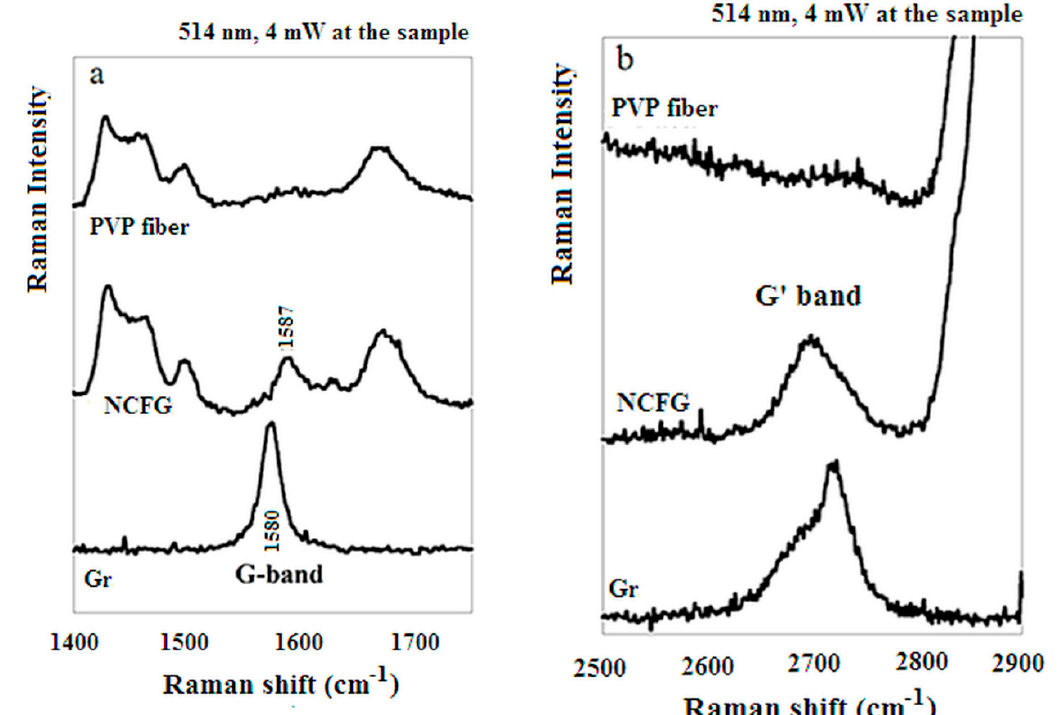
Figure 4. Raman spectra of PVP fibre, Noncovalently Functionalized Graphene (NCFG) and Graphite (Gr). ( a ) Raman shift range from 1400 to 1700 cm − 1 ; ( b ) Raman shift range from 2500 to 2900 cm − 1 .